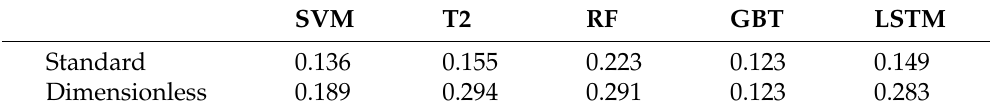
Table 3. False alarm rate for the different models.